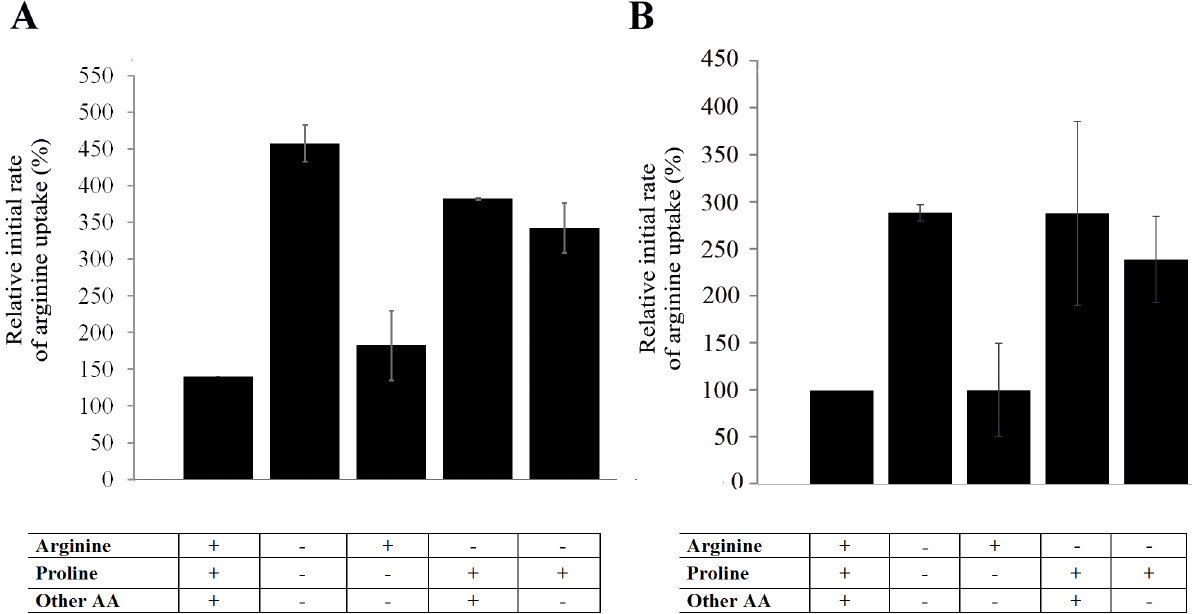
Fig 1. LdAAP3 response to deprivation is specific to arginine. Initial rates (up to 3 minutes) of arginine transport was determined in mid log-phase axenic L . donovani promastigotes (A) and amastigotes (B). Parasites (0.5-1X10 7 cells/ml) were incubated for 2 hours in medium 199 (pH 7 and 5.5 for promastigotes and amastigotes, respectively) with or without the amino acids indicated in the X-axis of each panel. Subsequently, cells were washed twice in EARL's salt solution and subjected to arginine transport assays using the rapid filtration technique as described in Materials and Methods. Radiolabeled amino acids were added at medium 199 concentrations. Values are the mean ± S.D. of three independent repeats. Transport rate at 100% was 0.4 ± 0.05 nmol/min/1X10 8 cells in promastigotes and 0.8 ± 0.1 nmol/min/1X10 8 cells in